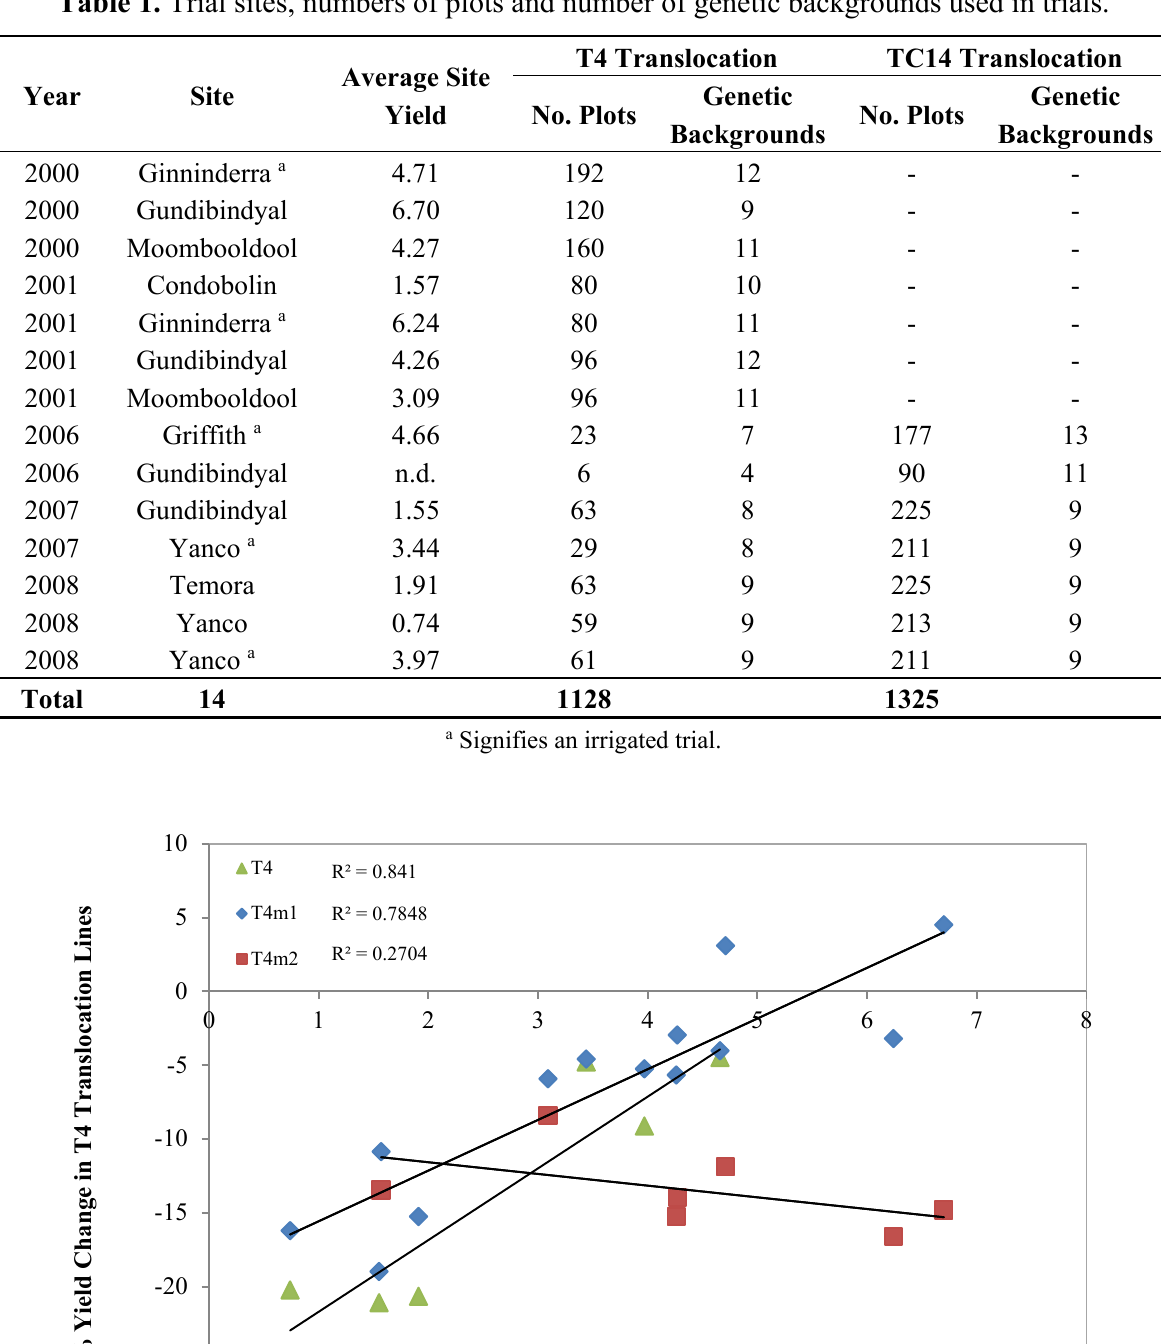
Table 1. Trial sites, numbers of plots and number of genetic backgrounds used in trials.